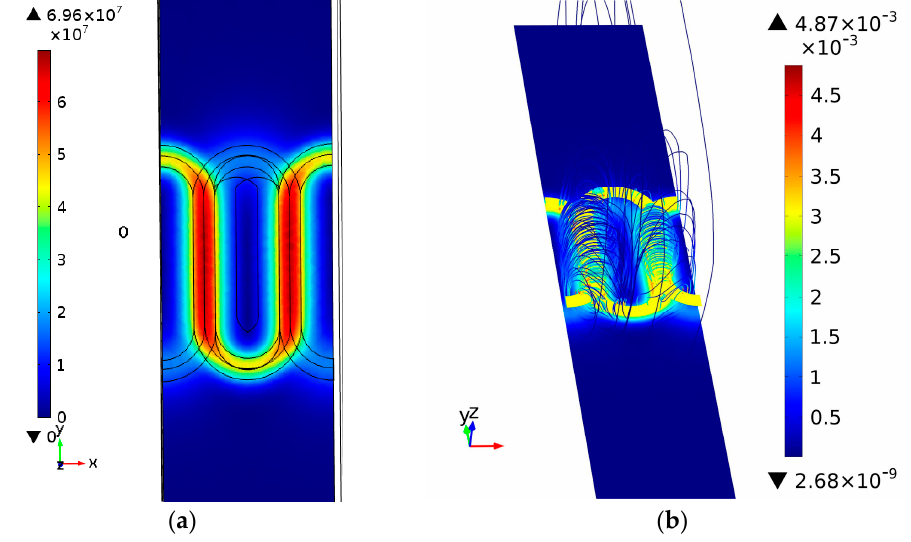
Figure 2. ( a ) Distribution of eddy currents; ( b ) Distribution of magnetic fields.